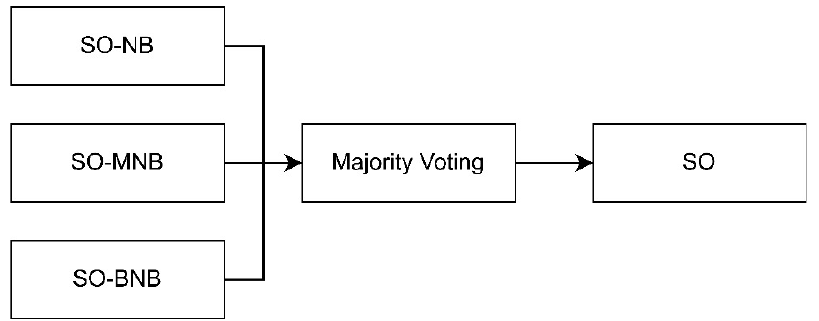
Figure 2. Determining SO using the majority voting of ML algorithms.